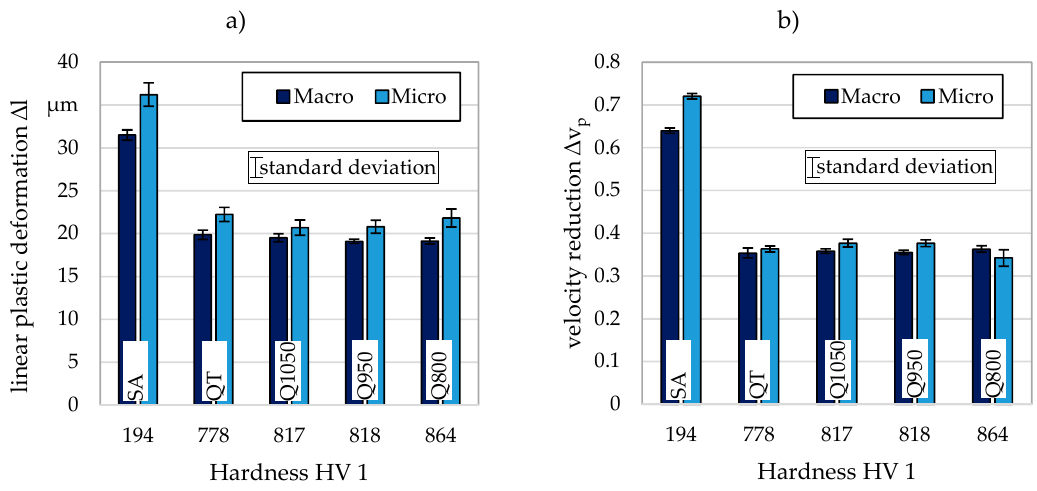
Figure 6. Comparison of ( a ) the linear plastic deformation and ( b ) the velocity reduction due to the impact; Macro: Macroscopic value (single-impact peening; n ≥ 5), Micro: Microscopic value (particle-oriented peening; n = 25).